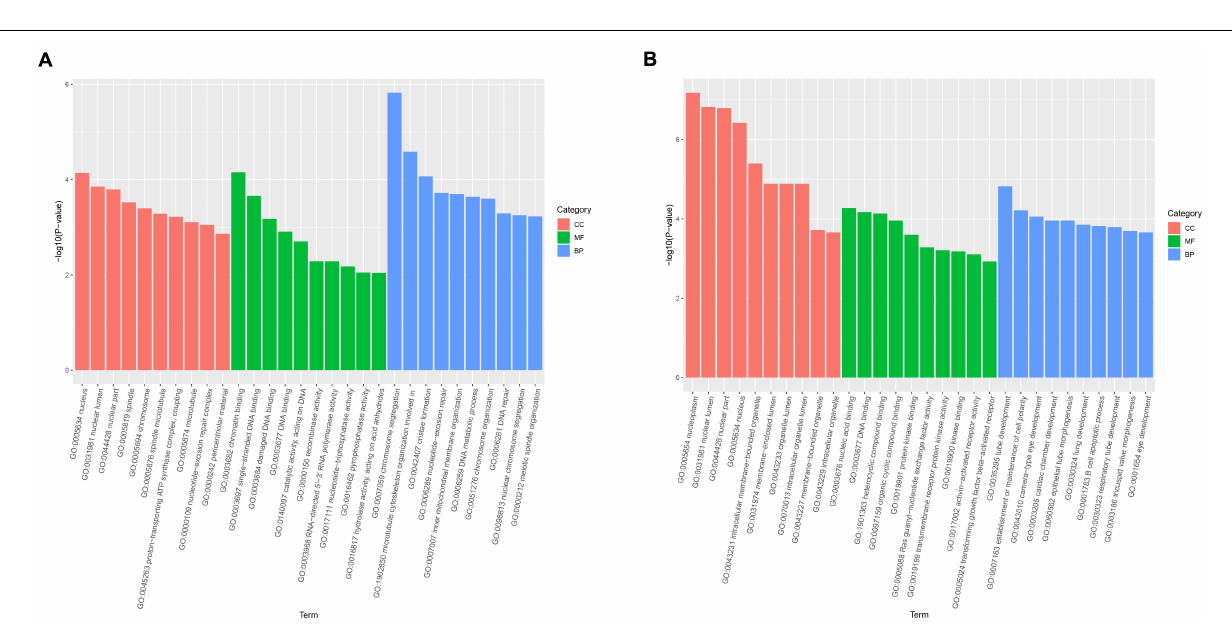
Frontiers in Genetics |